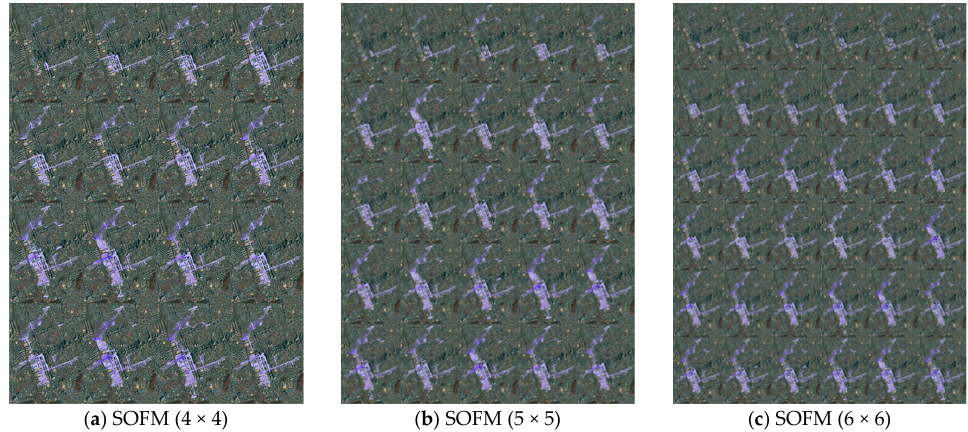
Figure 10 . Optimal flooding maps by SOFM dimension. Figure 10. Optimal flooding maps by SOFM dimension.